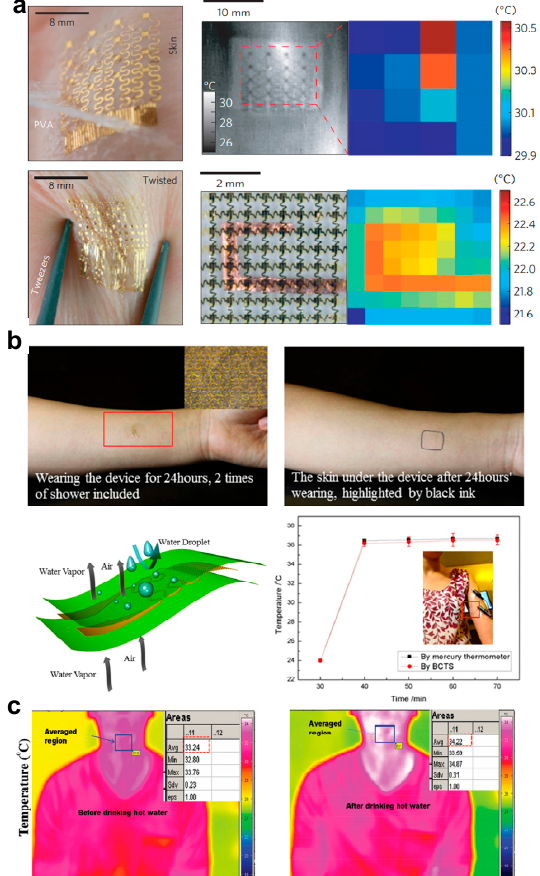
Figure 7. Examples of skin sensors for temepature measurement: ( a ) epidermal sensors that can monitor skin temperature using metallic and semiconductor sensors (Reprinted with permission